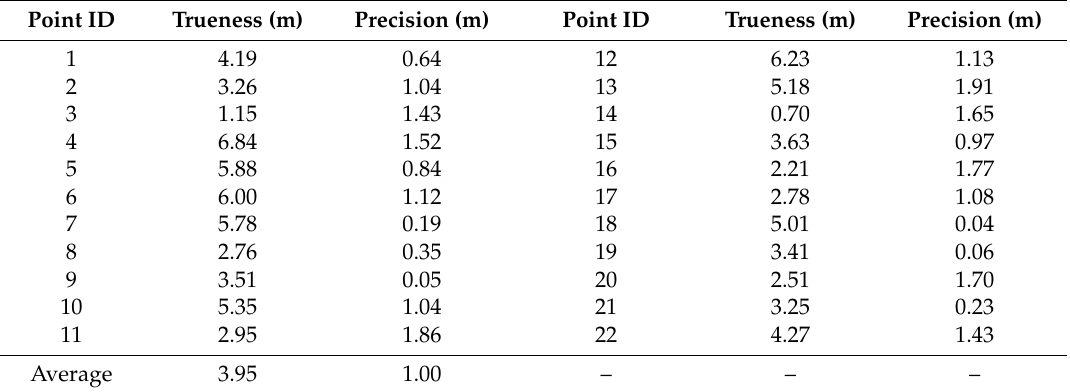
Table 2. Result of spatial accuracy of the 22 manually mapped road points. Trueness is the distance between the average position and the corresponding real position (m). Precision is the mean square error of the points by different operators (m).